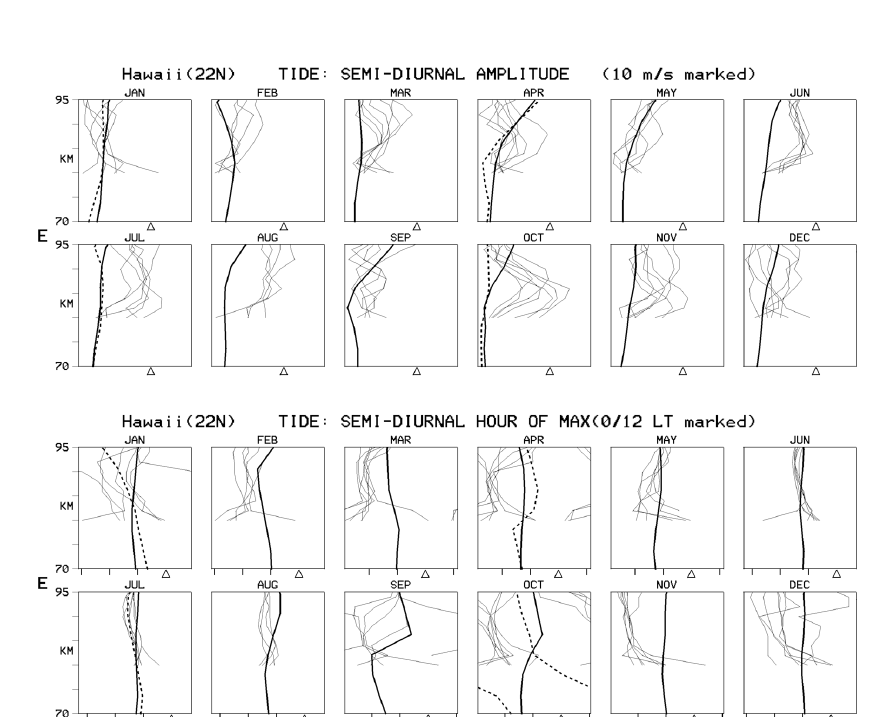
Fig. 1. Profiles of the Semi-Diurnal (12h) Tide amplitudes and phases for the zonal ( E ) component at Saskatoon. The thin lines are for the 6 years of MFR data, the dashed lines for GSWM (original 1995) and the thick lines for GSWM2000. The triangles on the am- plitude plots refer to the 10m/s val- ues. For the phase plots the total phase displayed is 12h; the triangles are at 00:00 and 12:00LT and their positions are chosen to minimize the number of phase discontinuities (“wrap-around”).